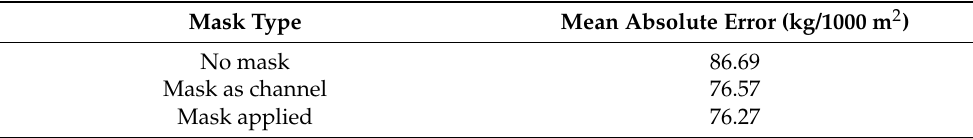
Table 6. Hybrid CNN results with and without masks.